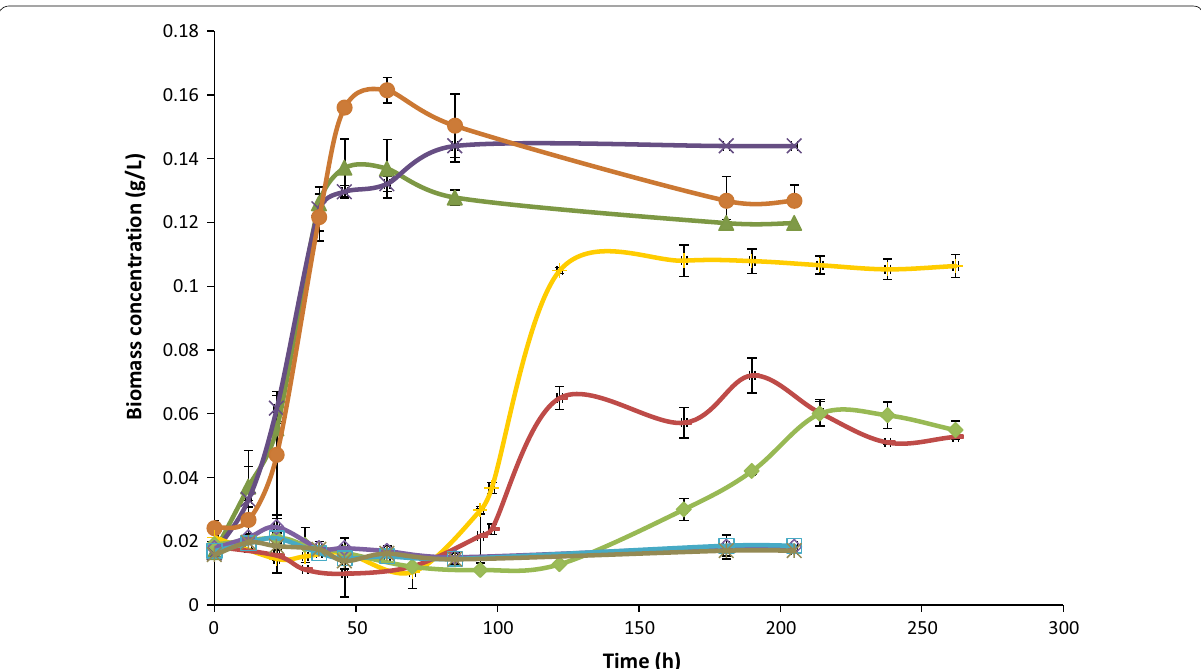
Fig. 4 Measured biomass concentration expressed as g/L over time. (0.2 g/L of sodium chloride represented as filled triangle, 3 g/L of sodium chloride represented as X, 9 g/L of sodium chloride represented as filled circle, 10 g/L of sodium chloride represented as chloride represented as , 12 g/L of sodium chloride represented as filled diamond, 15 g/L of sodium chloride represented as open diamond, − 18 g/L of sodium chloride represented as open square and 21 g/L of sodium chloride represented as